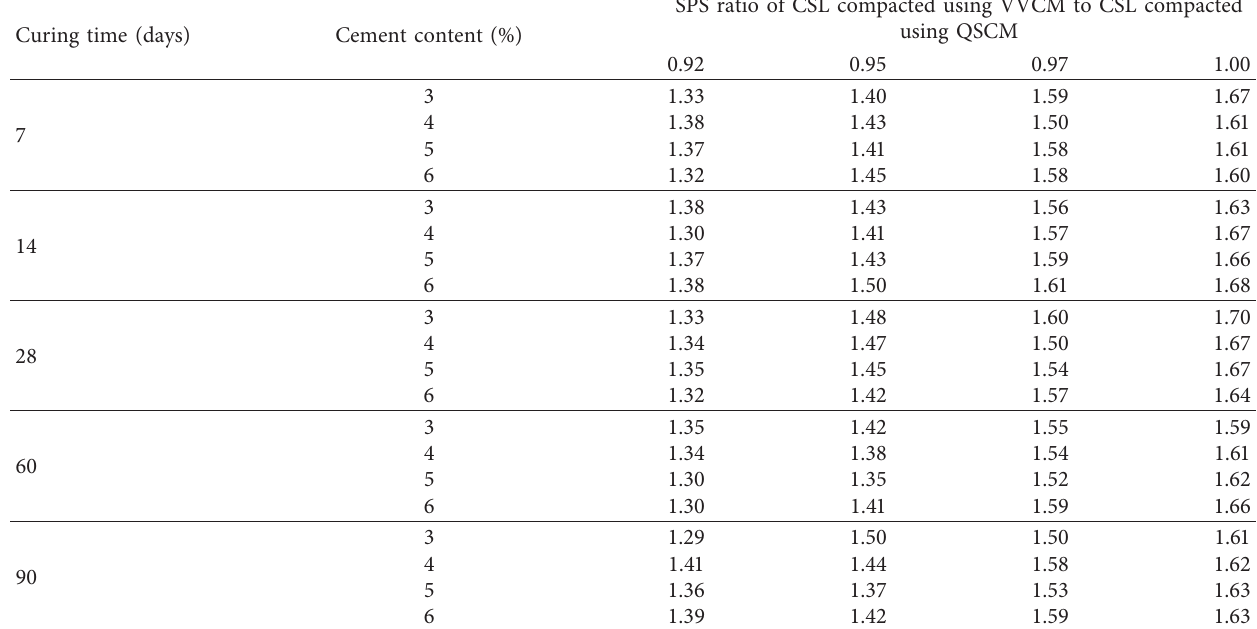
Table 9: SPS ratio of CSL compacted using VVCM to CSL compacted using QSCM. Curing time